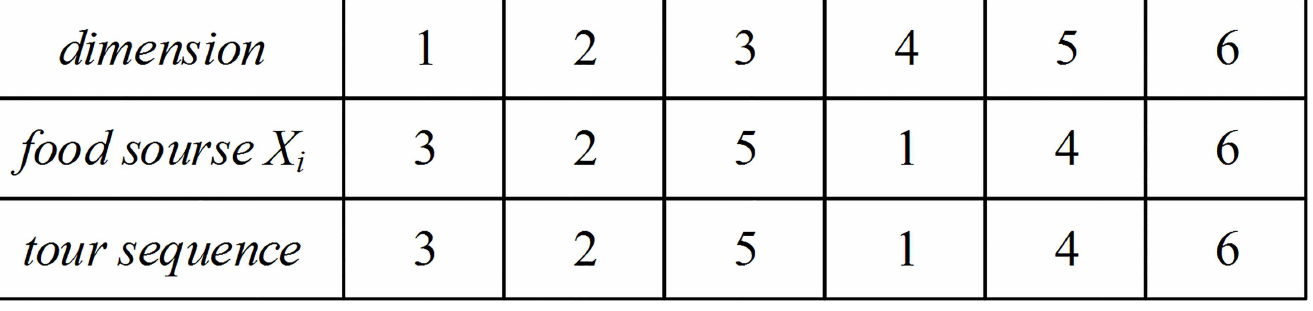
Fig 1. Food source and its corresponding